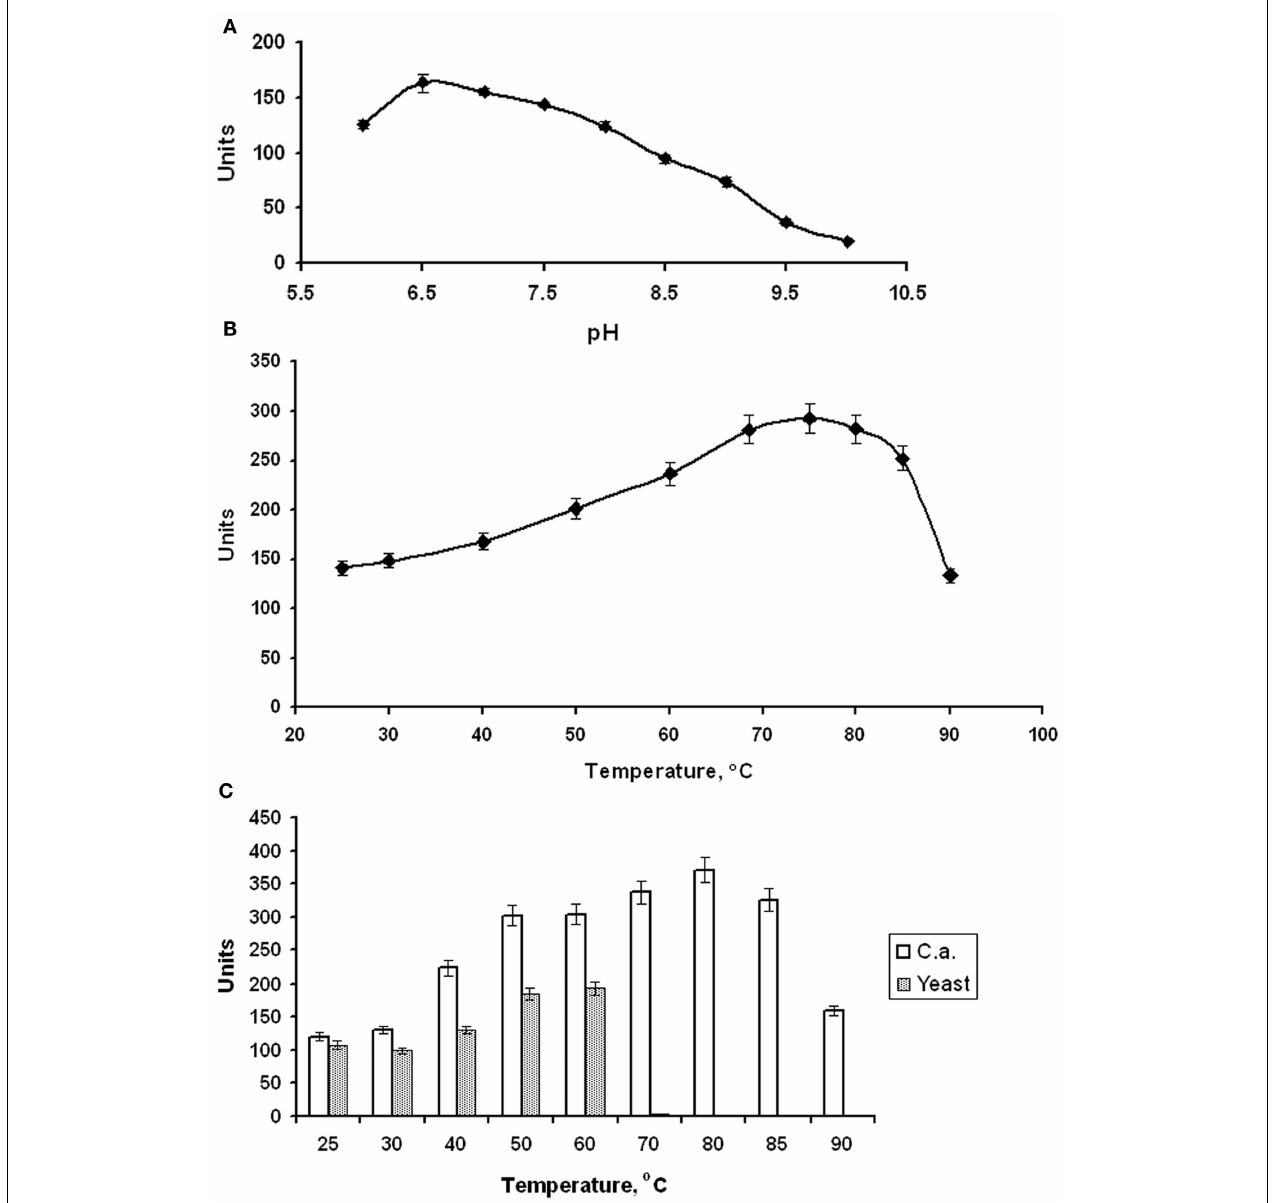
FIGURE 2 | Properties of C. aurantiacus enolase . (A) Determination of pH optimum. (B) Thermostability of C. aurantiacus enolase. (C) Comparison of temperature optimum of C. aurantiacus and Saccharomyces cerevisiae enolases.